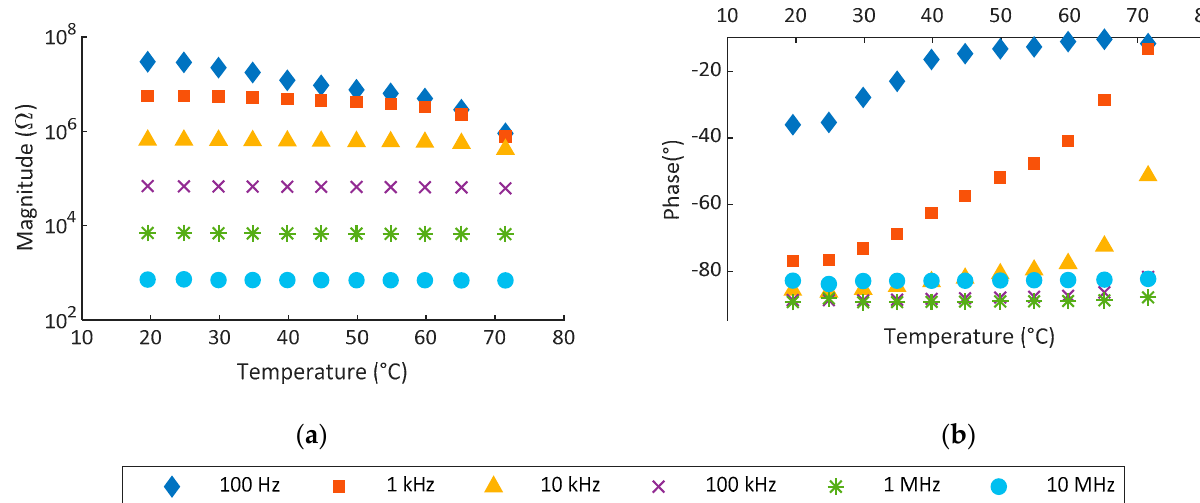
Figure 11. Impedance response towards temperature at RH of 55%. ( a ) Magnitude and ( b ) phase for spray-deposited Na-Pery.